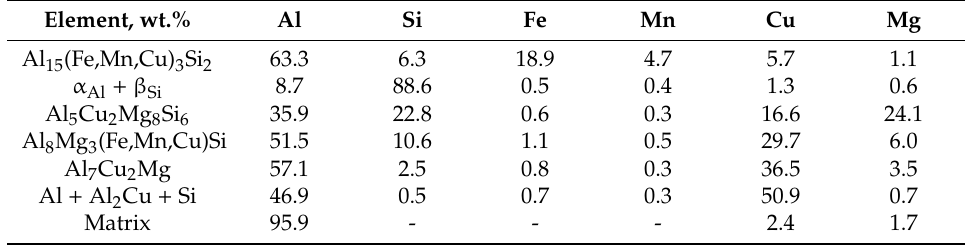
Table 4. EDS analysis of the intermetallic compounds present in AlSi7MgCu alloy. Element,